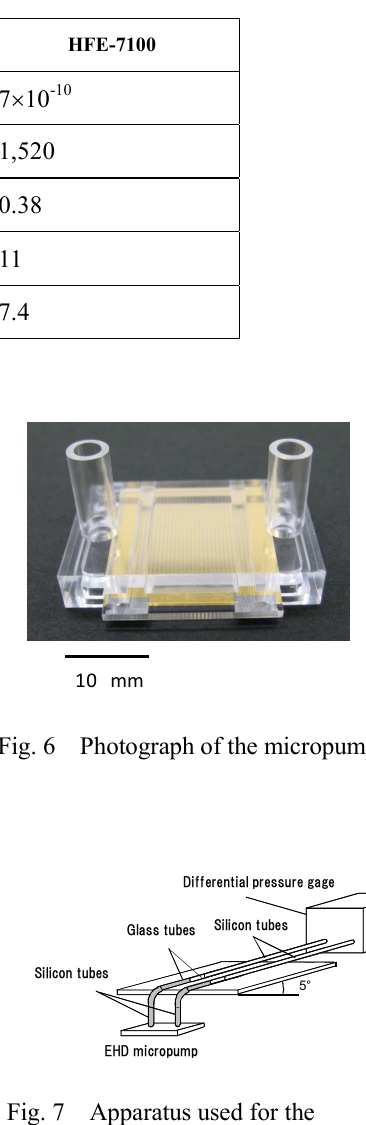
Fig. 7 Apparatus used for the measurement of static pressure